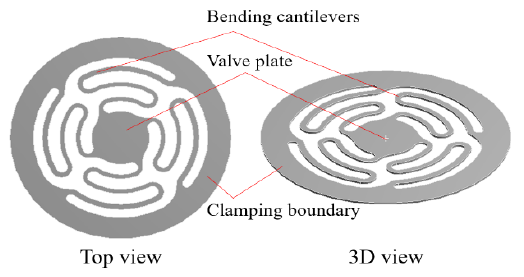
Figure 2. Thin-plate spring-type check valve.